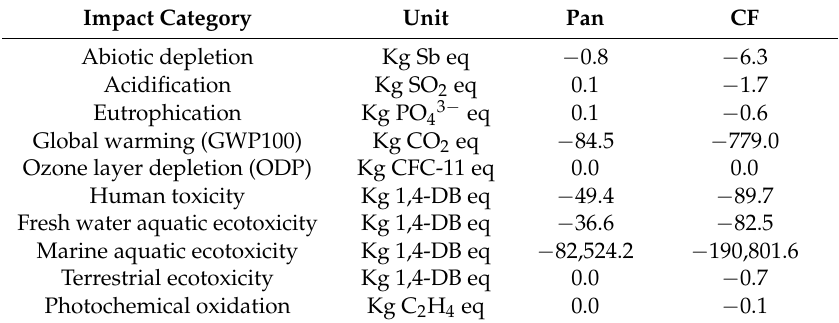
Table 7. Avoided impact of recycling 35.5 kg of CF composite through the Connora process: comparison of recovering the carbon fibres as PAN or as reusable CF. Method CML 2000.